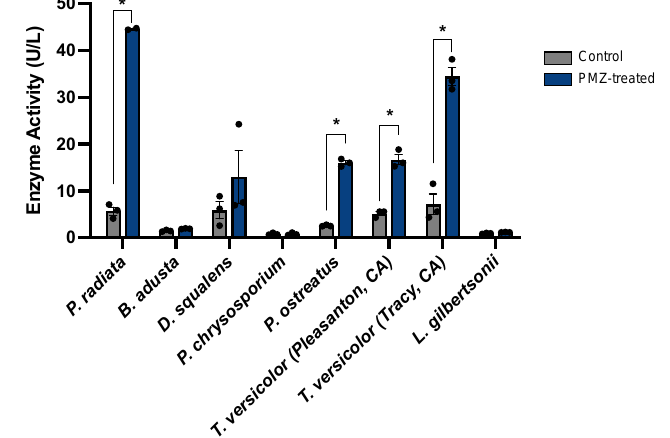
Figure 5. Promethazine induction of laccase activity in other wood-degrading fungal species. Laccase activity in media supernatants collected from diverse fungal species +/ − promethazine treatment. Samples were analyzed for extracellular laccase activity at 4 days post treatment using ABTS assays (data from additional time points are displayed in Supplementary Figure S6). Bars represent the mean of 3 biological replicates with individual data points shown, and error bars depict the standard error of the mean. Statistical significance is denoted as * for p < 0.01.